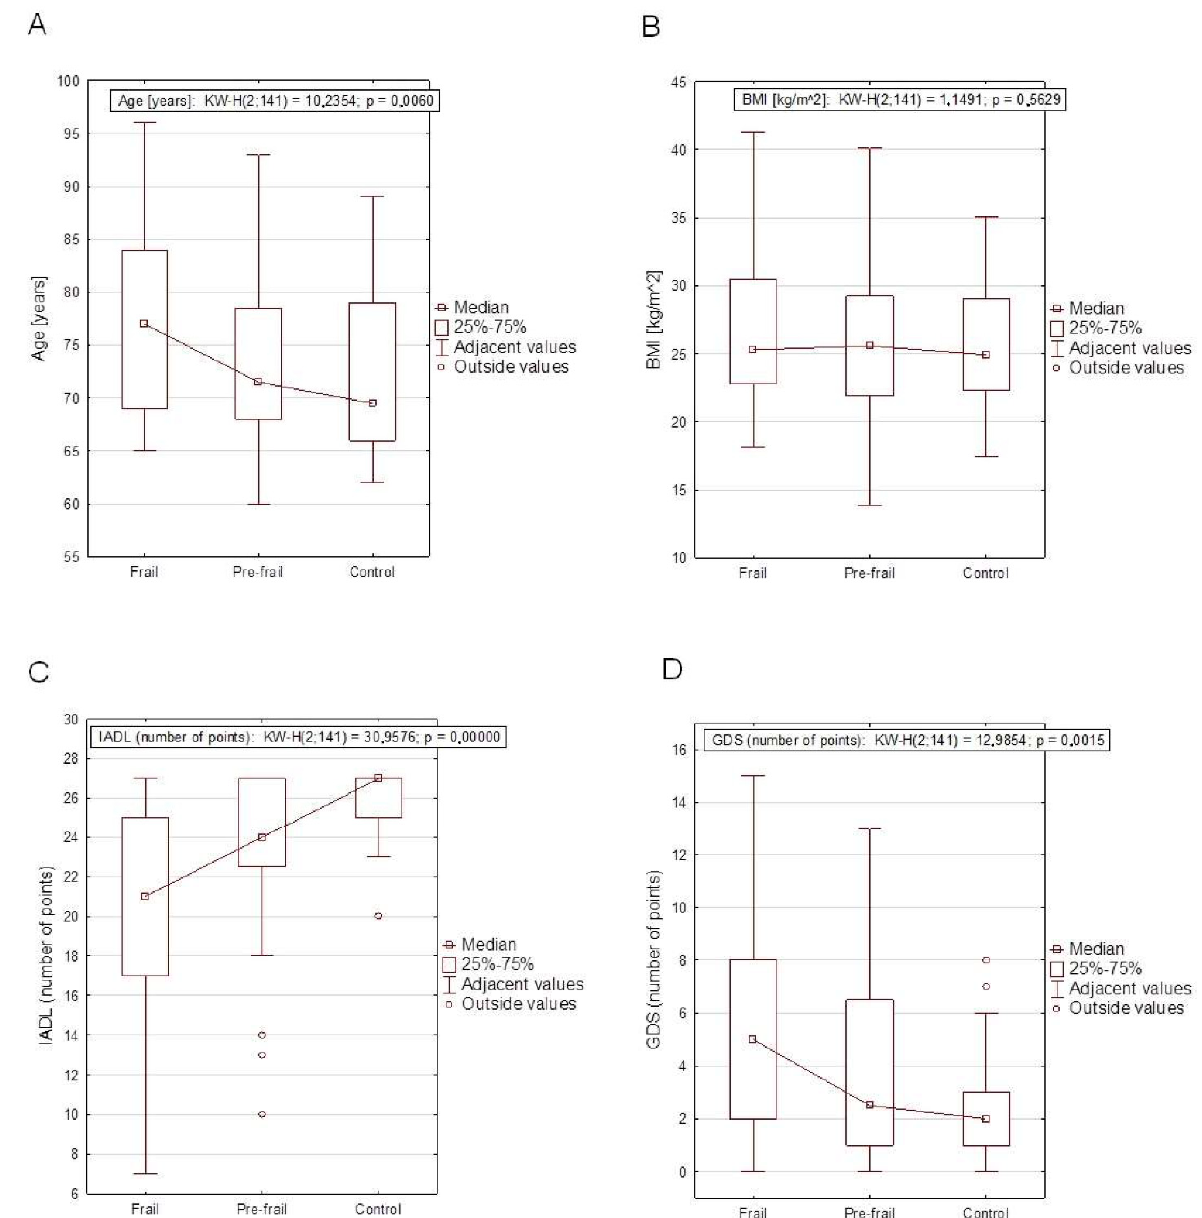
Figure 1. Box-plot graphs among Frail, Pre-frail and Control groups with the results of the Kruskal–Wallis test of age—( A ); body mass index (BMI)—( B ); instrumental activities of daily living (IADL)—( C ); geriatric depression scale (GDS)—( D ). Odds ratios obtained in one-factor analysis are presented in Table